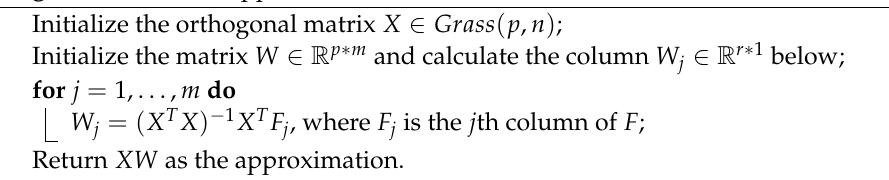
Algorithm 3 Matrix approximation on the Grassmann manifold.